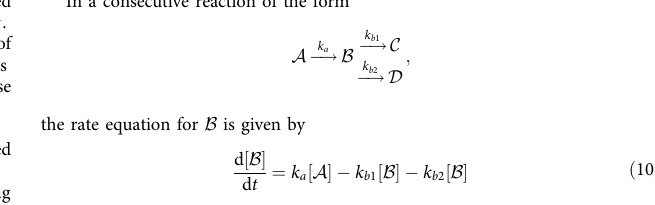
Fig. 6 The relaxation mechanisms that occur upon photoexcitation of linear C (cid:1)